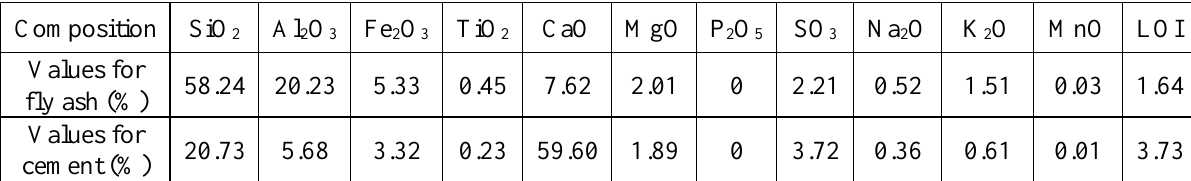
Table 2. Mixture composition of SCC in kg/m